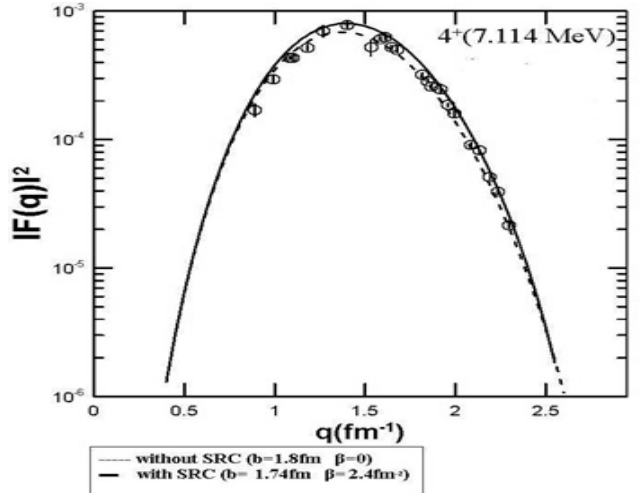
Fig. 6: Inelastic Coulomb 4 C form factors for the transition to the 14 + (7.114 MeV) state. The dashed and solid curves are the calculated 4 C form factors without and with the inclusion of the effect of the SRC, respectively. The open circle symbols are those of the experimental data taken from [33].